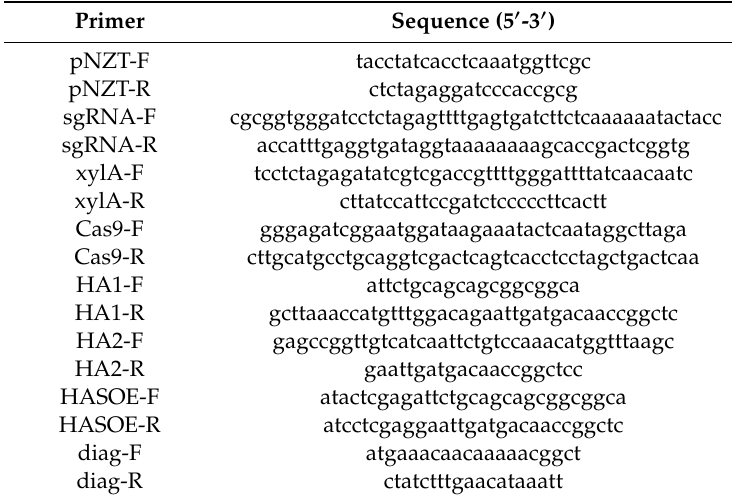
Table 2. Primers used in this study 1